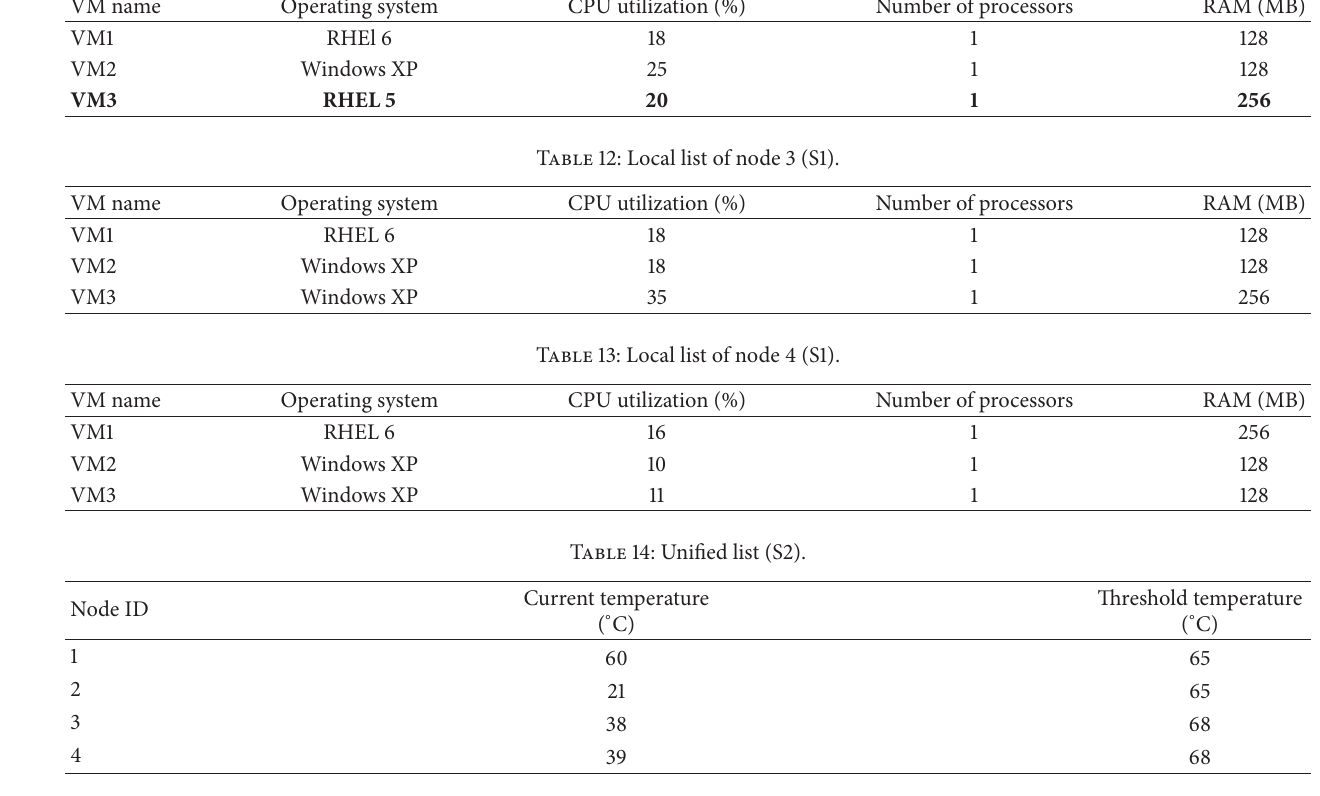
Table 15: Local list of node 1